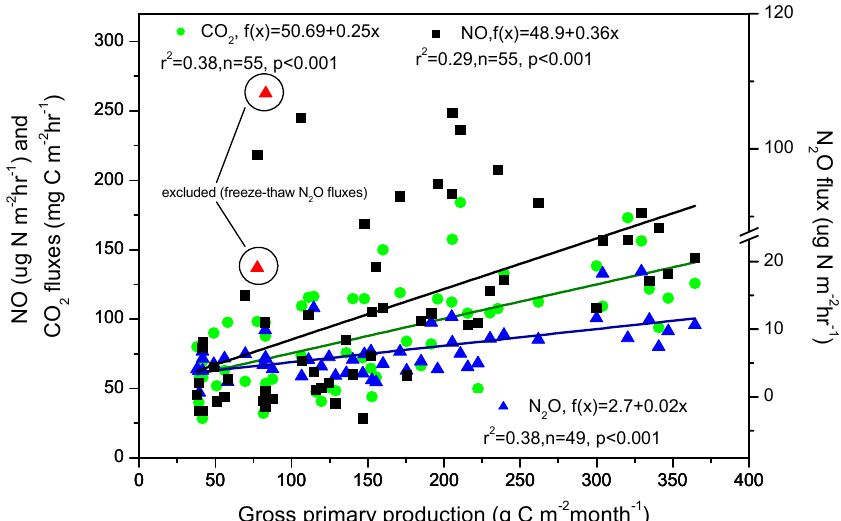
Fig. 10. Correlation of monthly aggregated gross primary production (GPP) with soil CO 2 , N 2 O and NO fluxes. GPP measurements were available from March 2006